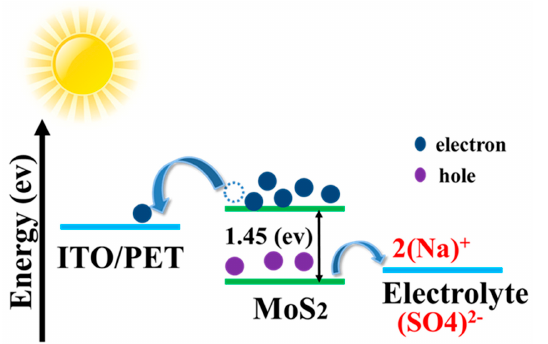
Figure 7. Energy band diagram of ITO/PET/MoS2/Electrolyte interfaces.